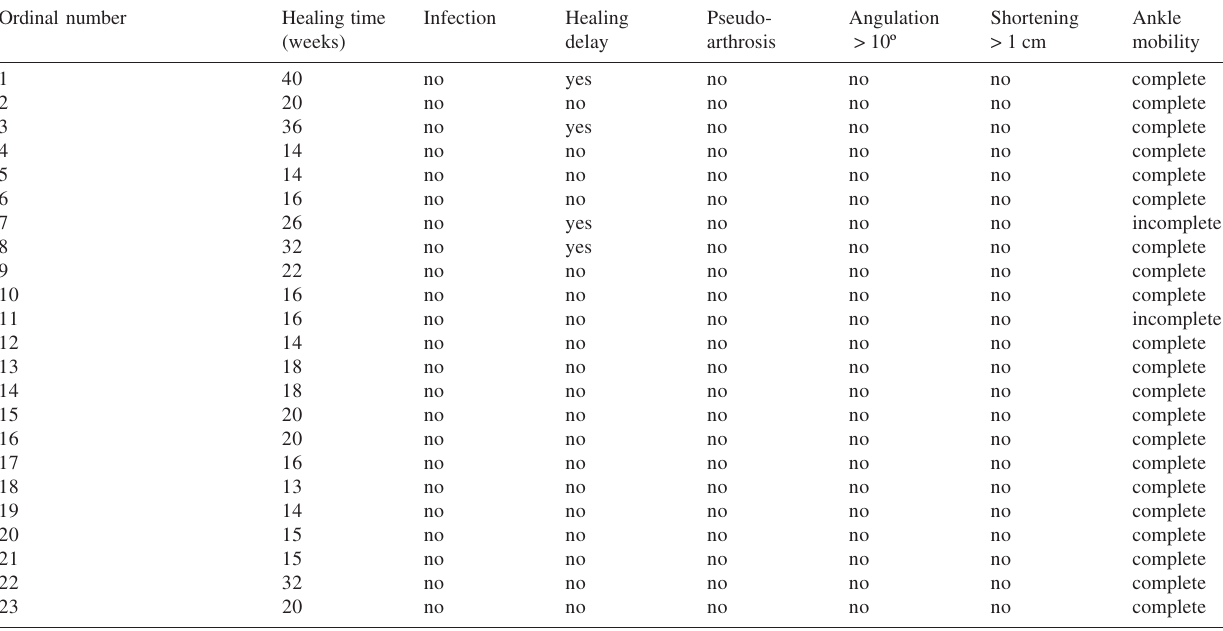
Table 5 - Individual results for patients undergoing surgical treatment with intramedullary nails: ordinal number, healing time, infection, healing delay, pseudoarthrosis, angulation, shortening, and ankle mobility Ordinal number Healing time Infection Healing Pseudo- Angulation Shortening Ankle (weeks) delay arthrosis mobility